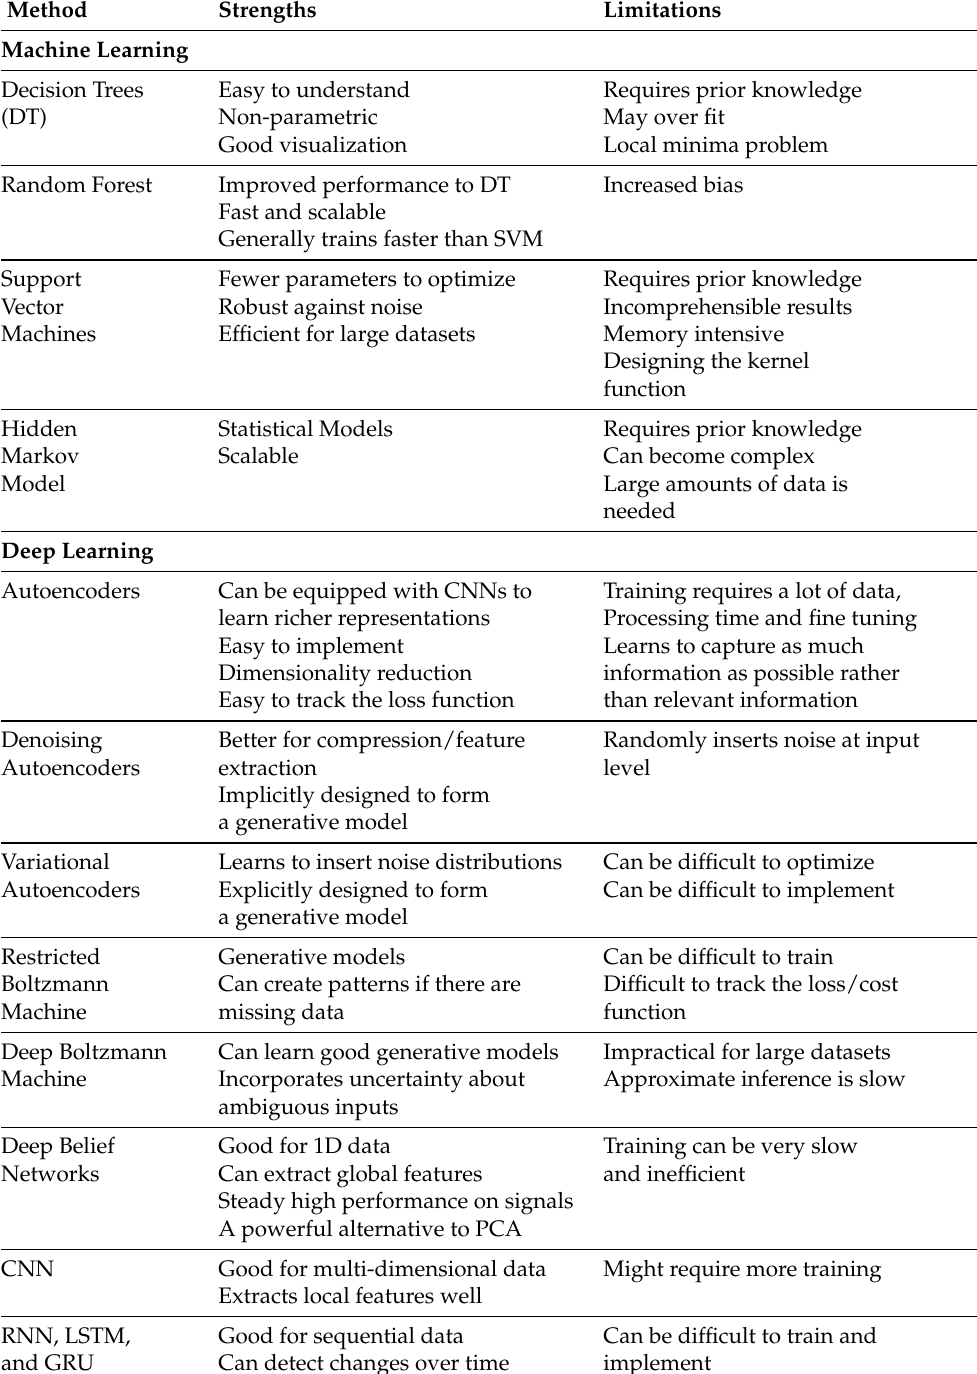
Table 1. Overview of machine learning and deep learning approaches for health management systems